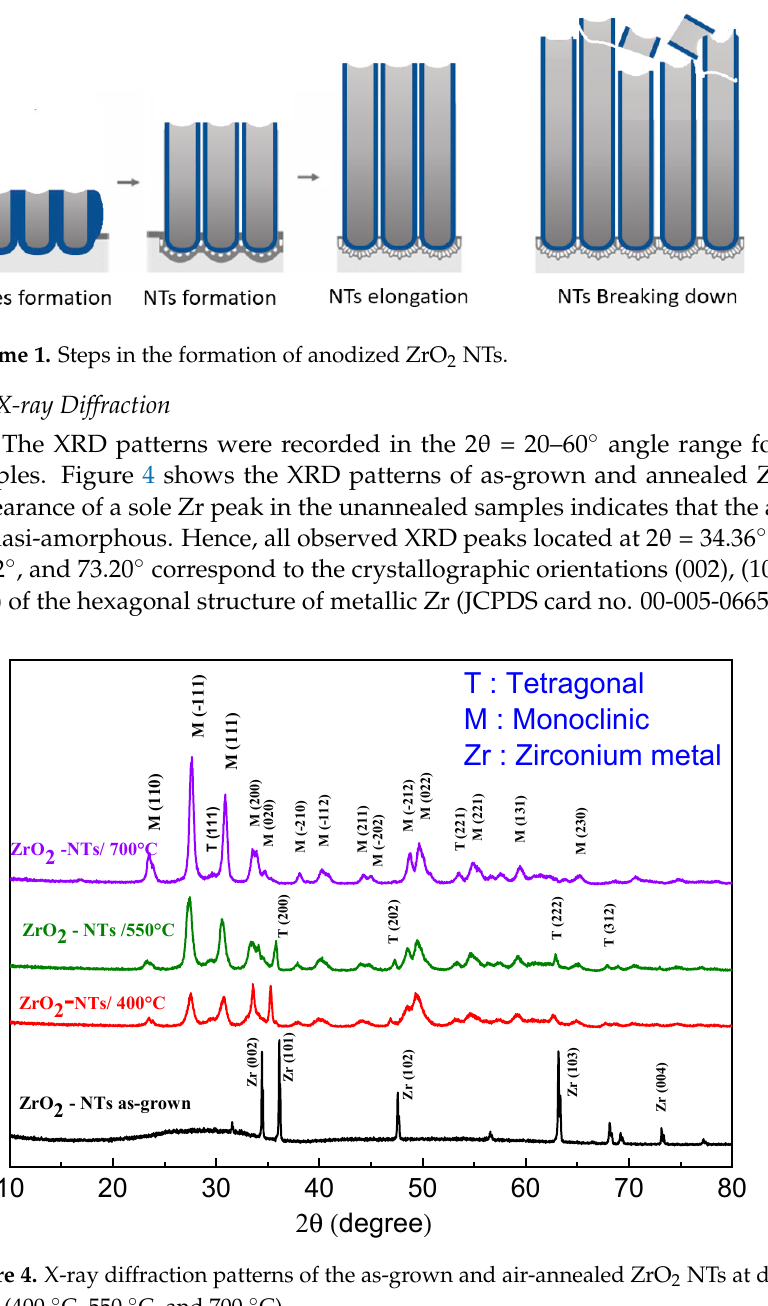
Figure 3. EDX spectrum of ZrO 2 NTs annealed at 550 °C.